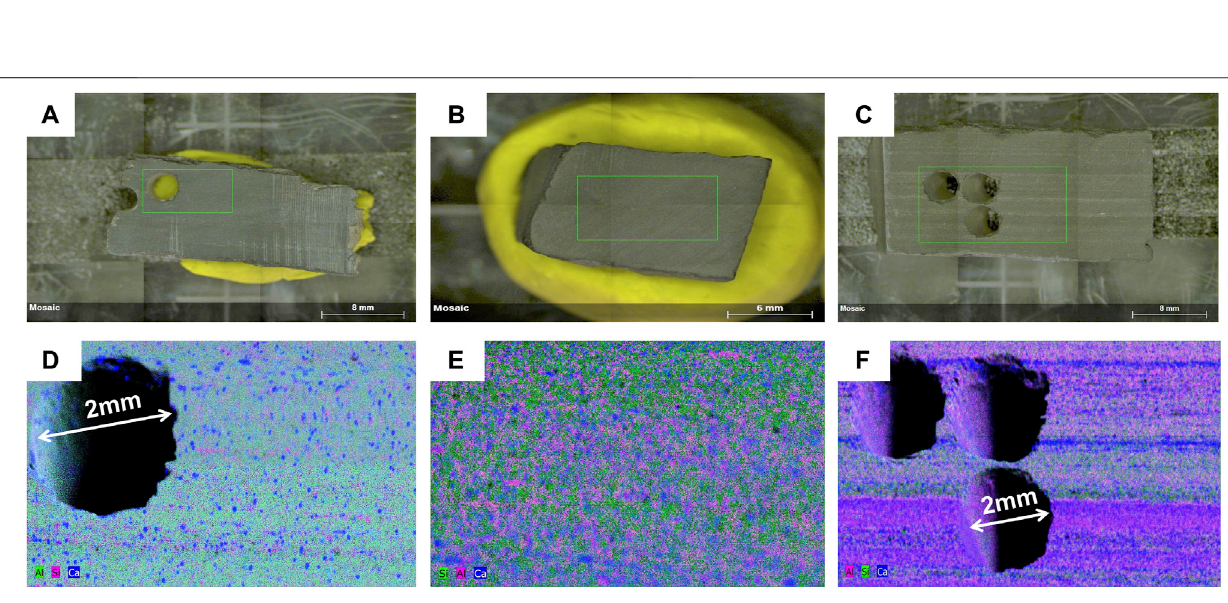
Frontiers in Earth Science |